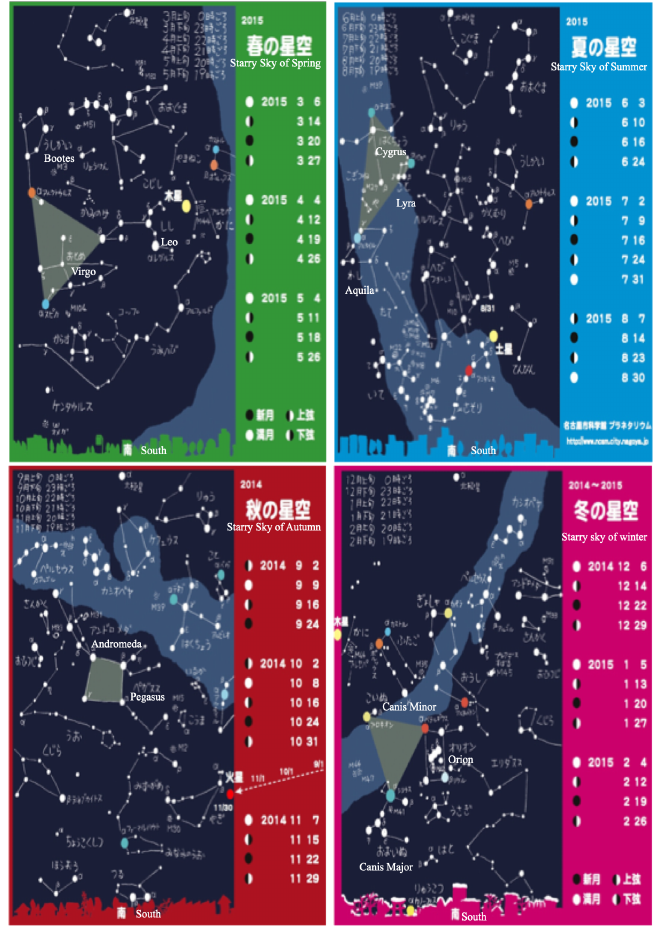
Figure 2. Planetarium materials of seasonal constellations in the south starry sky: ( upper left ) spring constellations; ( upper right ) summer constellations; ( bottom left ) autumn constellations; ( bottom right ) winter